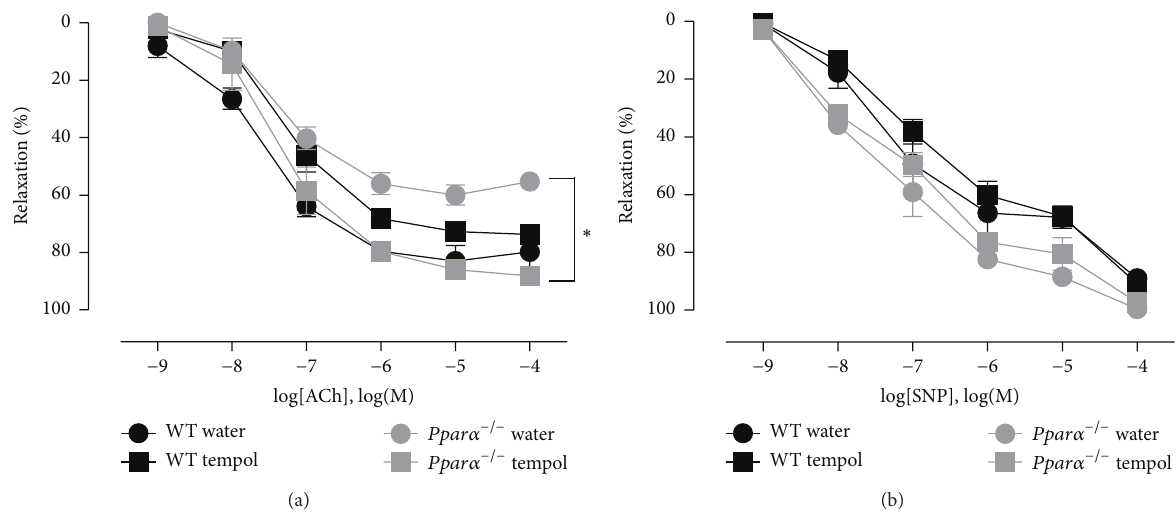
Figure 6: Tempol restored aortic relaxation in Ppar 𝛼 −/− mice. (a) Relaxation response curves to ACh and (b) SNP in WT and Ppar 𝛼 −/− mice after two weeks of water and tempol treatment. ∗ denotes statistical significance between tempol and water treated Ppar 𝛼 −/− mice ( 𝑝 < 0.05 ; 𝑛 = 3 animals). Data are means ±